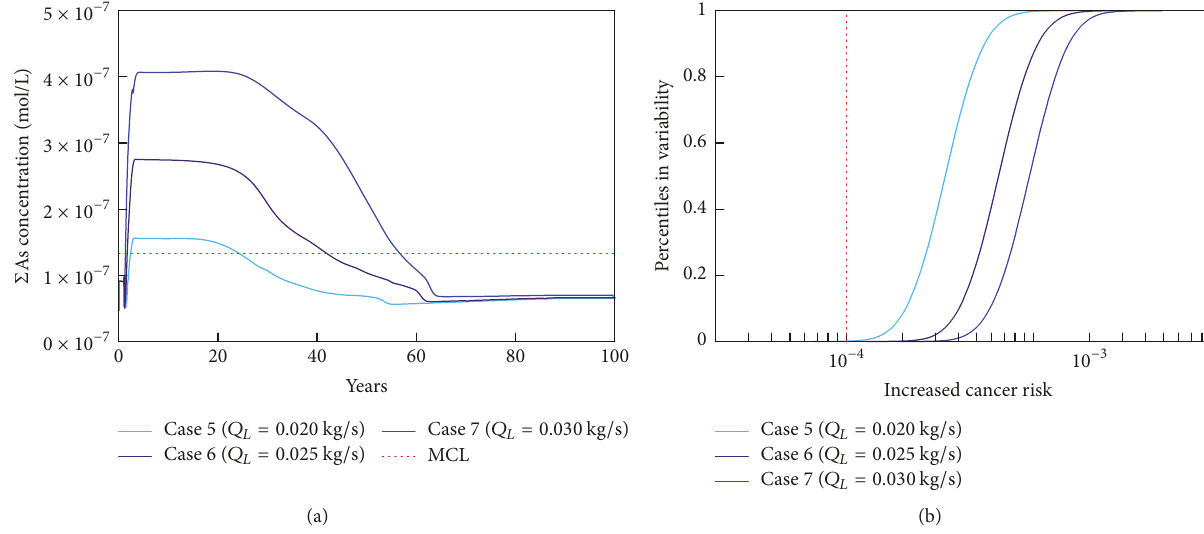
Figure 12: (a) ∑ As profiles with different leakage intensities ( 𝑄 𝐿 ) of 0.01, 0.02, and 0.03 kg/s (Cases 5–7) and (b) probabilistic health risk for Cases 5–7 plotted as cumulative density functions (CDF). The red dotted line represents the risk level of concern (10 −4 ).